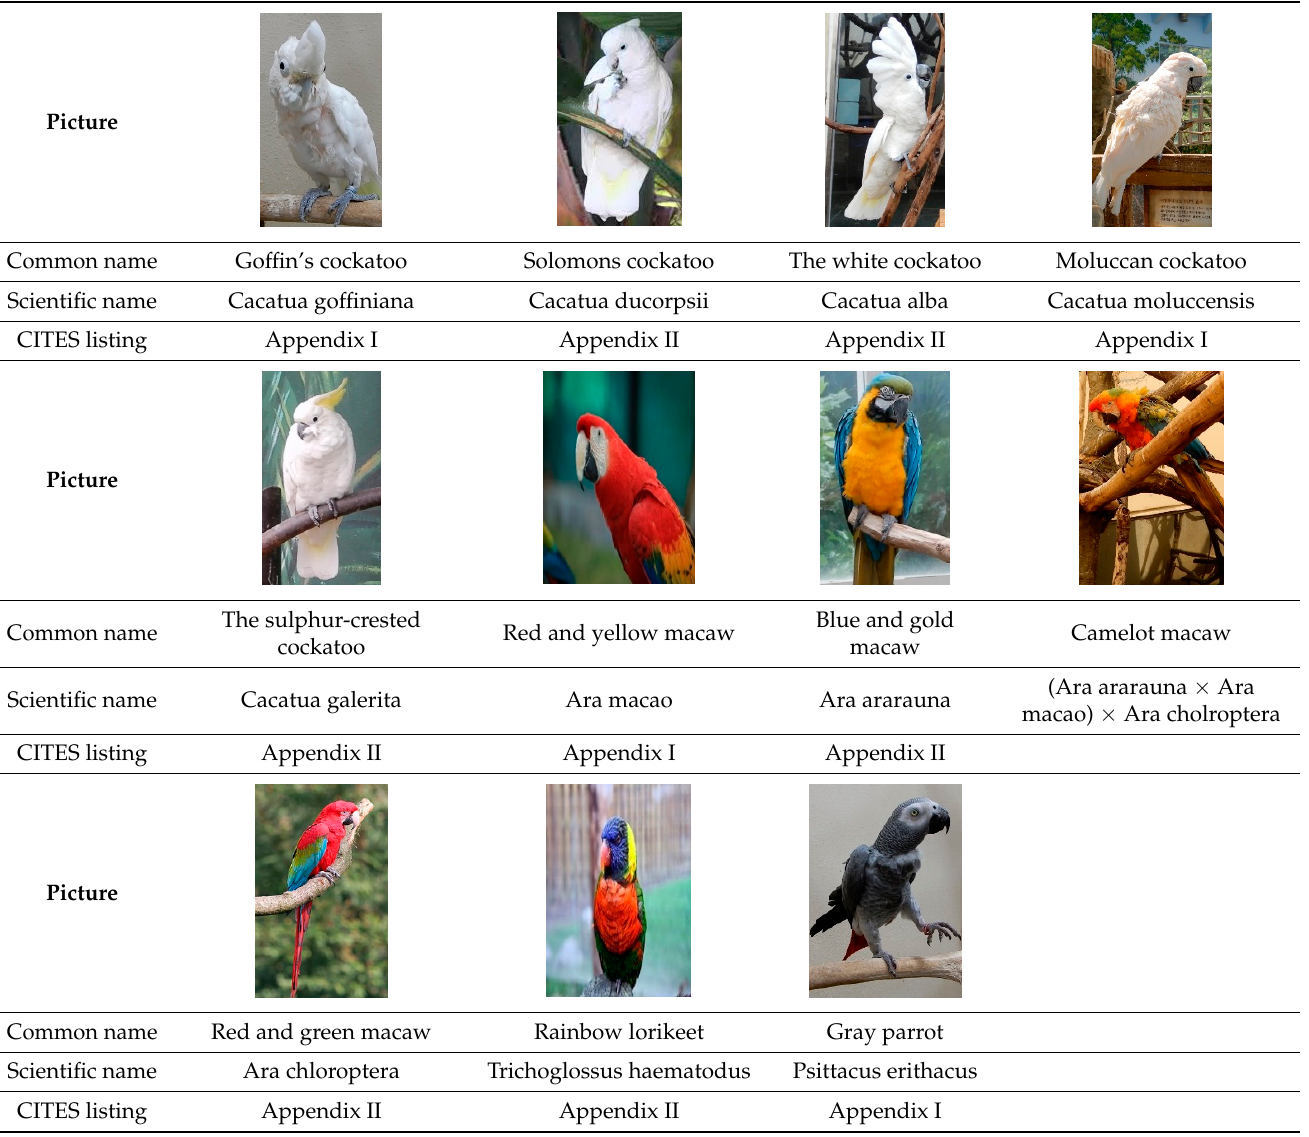
Figure 2. Data augmentation methods; red box represents the ground-truth.